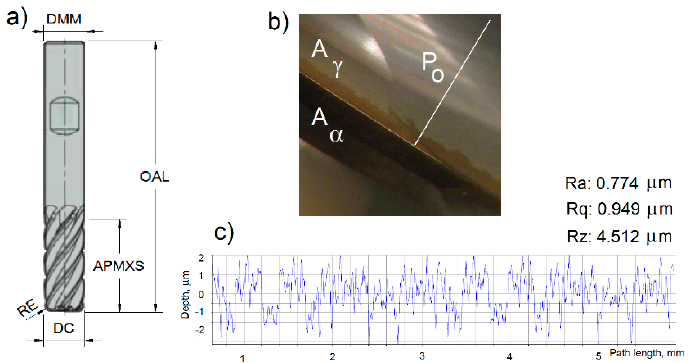
Figure 7. The ball end milling cutter and its dimensions. DMM = 20 mm, OAL =121 mm, APMXS = 62 mm, DC = 20 mm, Z = 6, ( a ) sketch, ( b ) the rake plane A γ , the flank plane A α , the orthogonal plane P o , ( c ) the surface roughness at the orthogonal rake plane P o .